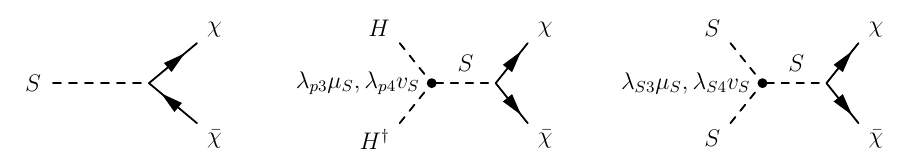
Figure 6 . The main production modes for the DM particle (cid:31) in the vev-induced freeze-in scenario. produced via freeze-in, facilitated by the processes S ! (cid:31) (cid:22) (cid:31) , H y H ! (cid:31) (cid:22) (cid:31) , and SS ! (cid:31) (cid:22) (cid:31) . The corresponding Feynman diagrams are shown in (cid:12)gure 6, and the decay rates and annihilation cross sections